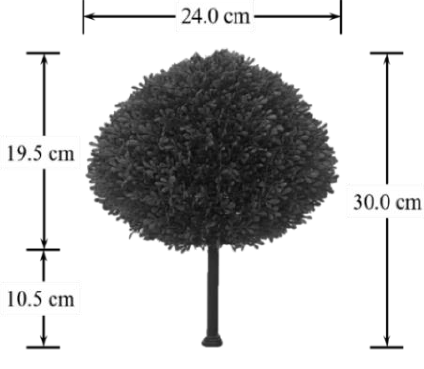
Figure 4. Schematic of the model tree.